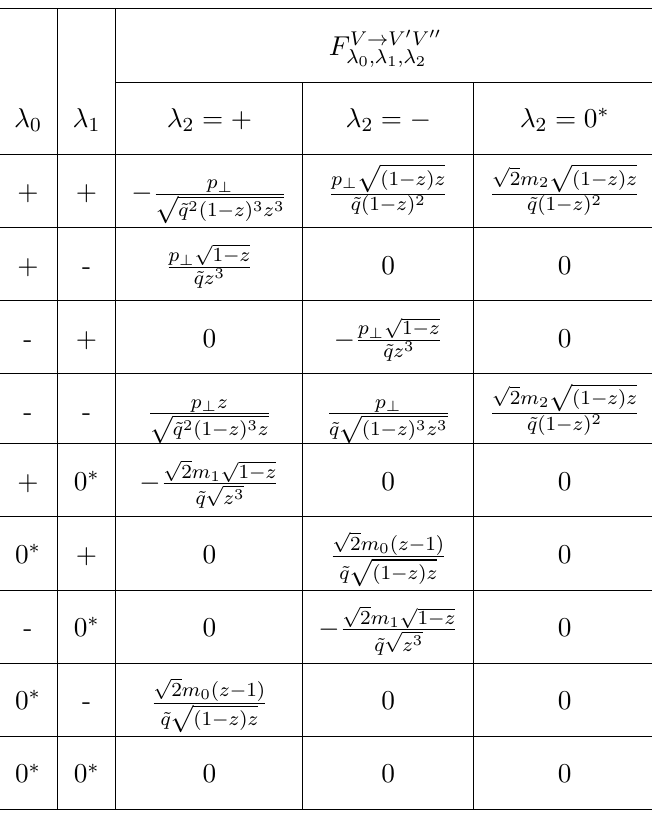
Table 3. Spin-unaveraged splitting functions for V → V 0 V 00 . In addition to the factors given above, each term has a phase e i ( λ 0 − λ 1 − λ 2 ) φ 0 , where λ 0 , 1 , 2 = ± , 0 ∗ represent the helicity states of the incoming. The longitudinal polarization states which are marked as λ 2 = 0 ∗ give the relevant components in Dawson’s approach [54] and can be used to eliminate singularities that appear in the p ⊥ (cid:29) m i , i = 0 , 1 , 2